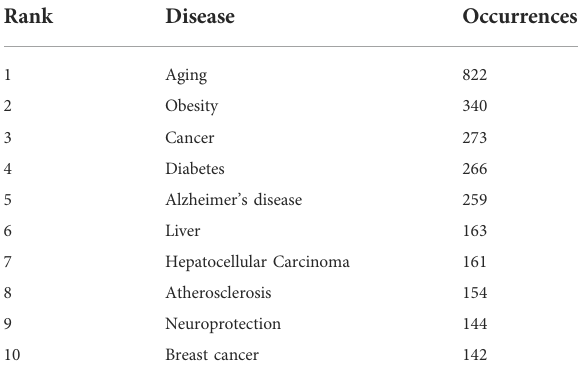
TABLE 1Topten diseasesmost signi fi cantly associatedwith sirtuins in publications. Rank